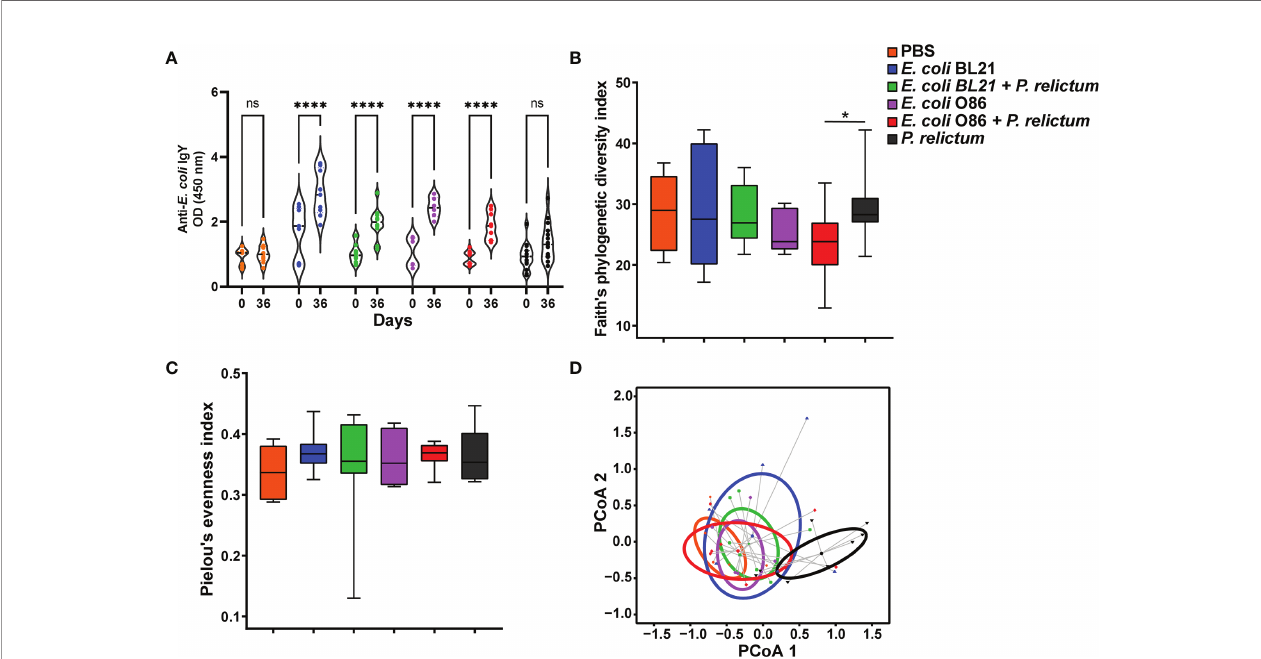
FIGURE 2 | Impact of anti-microbiota vaccine and P. relictum infection on bird antibody response and mosquitoes ’ microbial diversity. (A) Levels of IgY speci fi c to E. coli proteins were measured by semiquantitative ELISA in sera of canaries before immunization (day 0) and in sera of canaries immunized with a mock vaccine, E. coli BL21 and E. coli O86:B7 alone or challenged with P. relictum (day 36 after fi rst vaccination) (****p < 0.00001; ns, not signi fi cant). (B) Faith ’ s phylogenetic diversity and (C) Pielou ’ s evenness indexes were used to measure the richness and evenness, respectively, of microbiota of mosquitoes fed on canaries immunized with a mock vaccine, E. coli BL21 and E. coli O86:B7 alone or challenged with P. relictum . The asterisk indicates signi fi cative differences between groups (pairwise Kruskal-wallis, p = 0.03). (D) Beta diversity of mosquito microbiota in the different experimental conditions represented in PCoA plot obtained by Betadisper function. There were no differences in the intragroup dispersions (variances) (ANOVA, p = 0.426), whereas differences were found in the community composition between groups (PERMANOVA, p = 0.001), speci fi cally the group infected with P. relictum alone was different from the other groups. Taxonomic pro fi les at the level of ASVs, used to measure the alpha and beta diversity, were obtained from 16S rRNA sequences from midgut of mosquitoes fed on mock-immunized (n = 5 mosquitoes midgut pool), E. coli O86:B7-immunized (n = 5 mosquitoes midgut pool), E. coli O86:B7-immunized and challenged with P. relictum (n = 8 mosquitoes midgut pool) and challenged only with P. relictum (n = 8 mosquitoes midgut